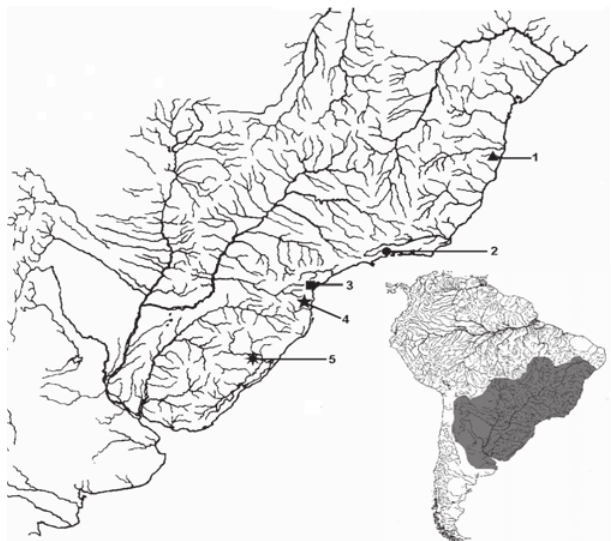
Fig. 4. Collection localities of Phalloceros mikrommatos (tri- angle, 1), P. enneaktinos (circle, 2), P. pellos (square, 3), P. malabarbai (five-pointed star, 4), and P. heptaktinos (eight- pointed star, 5). Some symbols represent more than one lot or locality. Numbers represent type localities. The inset is the range of the